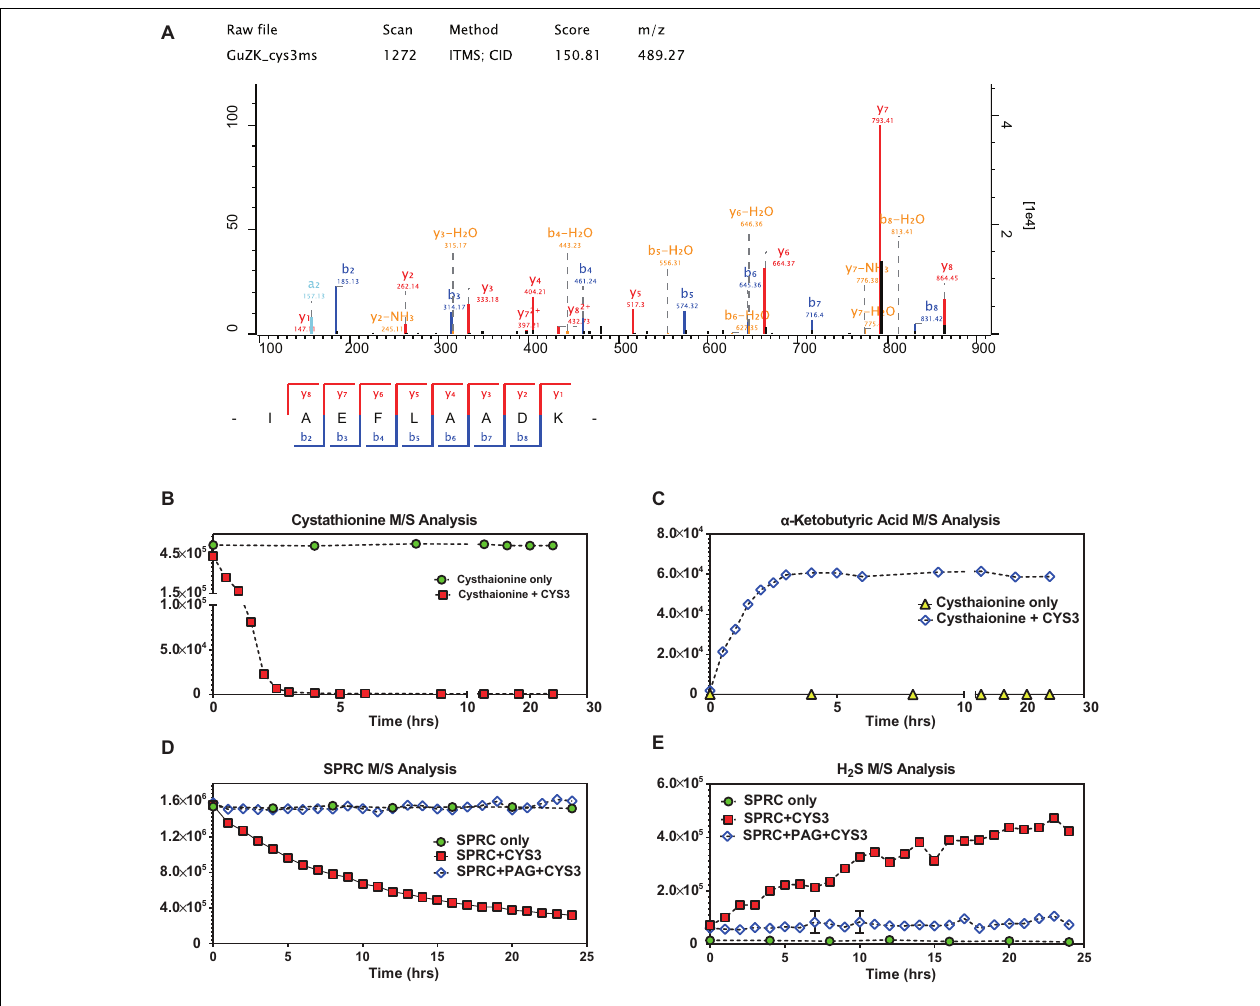
FIGURE 5 | S -propargyl-cysteine catalyzed by yeast cystathionine- γ -lyase. (A) The mass spectrometry analysis confirmed the identity of Cys3p (cystathionine- γ -lyase in S288C) purified from E. coli lysis. The sequence of the peptide of Cys3p has been identified as “IAEFLAADK,” which matched to the sequence of Cys3p by NCBI-BLASTp. The horizontal axis shows the molecular weight, and the vertical axis shows the signal intensity. (B) The mass spectrometry analysis showed relatively rapid decreasing signals of cystathionine when cystathionine was being catalyzed by purified Cys3p from 0 to 24 h, and non-decreasing signals of cystathionine without the Cys3p incubation. (C) The mass spectrometry analysis showed relatively rapid increasing signals of α -ketobutyric acid when cystathionine was being catalyzed by purified Cys3p from 0 to 24 h, and non-increasing signals of α -ketobutyric acid without the Cys3p incubation. (D) The mass spectrometry analysis showed relatively stable decreasing signals of SPRC when SPRC was being catalyzed by purified Cys3p from 0 to 24 h, and non-decreasing signals of SPRC when the catalysis inhibited by PAG. (E) The mass spectrometry analysis showed relatively stable increasing signals of H 2 S when SPRC was being catalyzed by purified Cys3p from 0 to 24 h, and non-increasing signals of H 2 S when the catalysis inhibited by PAG. (B–E) The horizontal axes indicate the incubation time (0–24 h). The vertical axes indicate the M/S signals of the detected molecules, including cystathionine, α -ketobutyric acid, SPRC and H 2 S. The data of triplicates was represented as mean ±